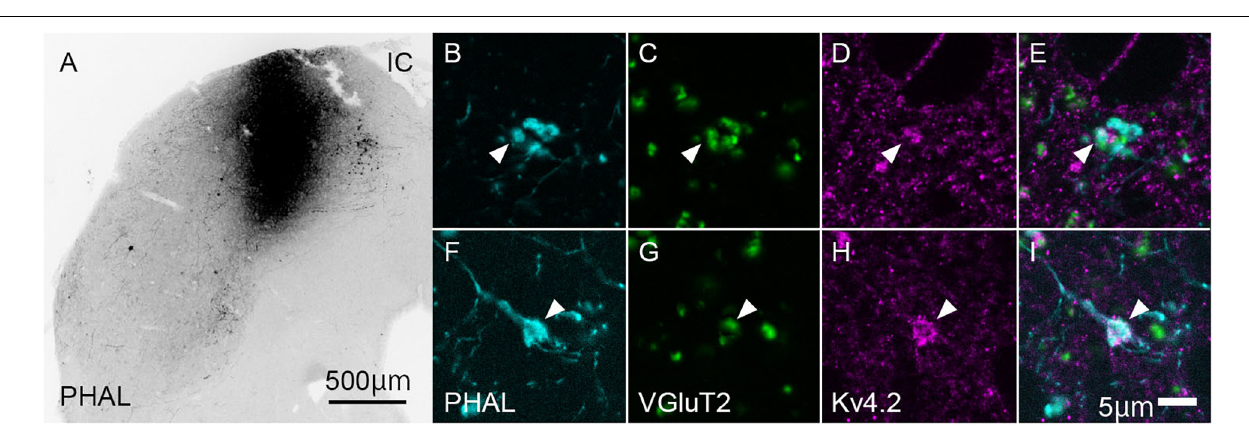
FIGURE 5 | Kv4.2-positive processes from MGB neurons receive excitatory (VGluT2) inputs from the IC. (A) An example of the coronal section of IC showing the center of injection of Phaseolus vulgaris -leucoagglutinin (PHAL). (B–I) Triple immunofluorescence for PHAL (cyan; B,E ), VGluT2 (green; C,G ), and Kv4.2 (magenta; D,H ), in the mice MGV. (E,I) Images are acquired from different sections. Scale bars: 500 µ m (A) , 5 µ m (B–I) . IC, inferior colliculus; VGluT2, vesicular glutamate transporter